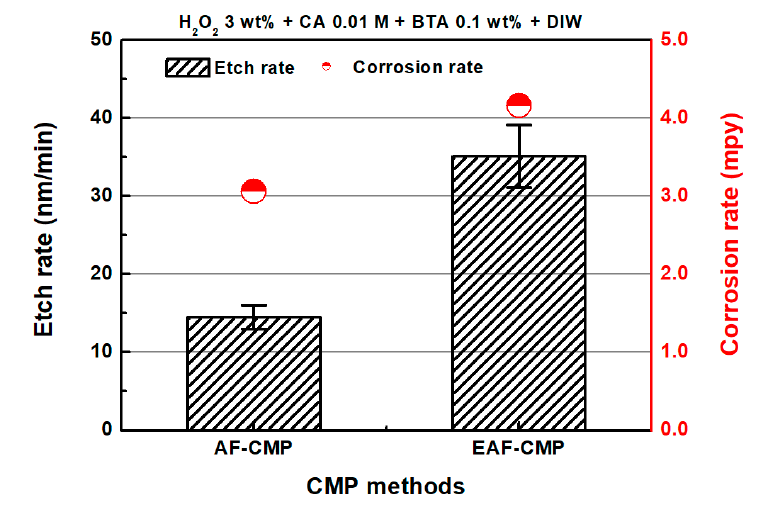
Figure 4. Etch rates and corrosion rates of AF-CMP and EAF-CMP.